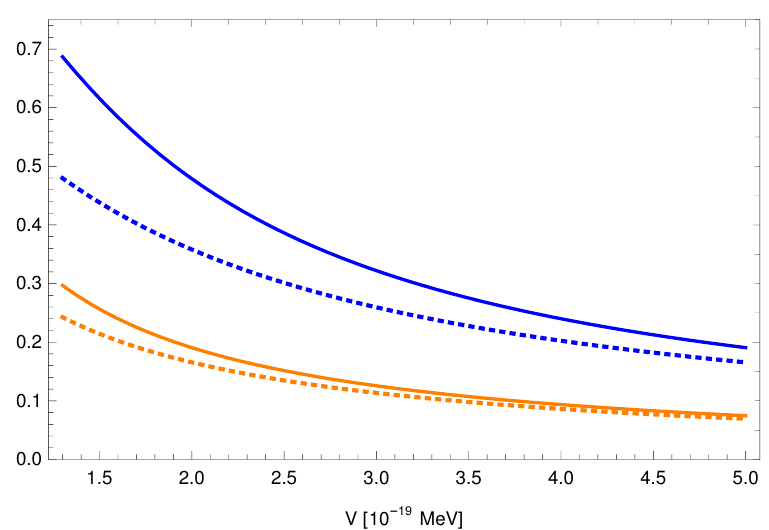
Figure 3 . sin 2 (cid:18) m in the matter for neutrinos (solid lines) and antineutrinos (dashed lines) as 12 the function of their interaction potential with Earth for energy E = 400 MeV (blue lines) and E = 1000 MeV (orange lines). Plots for the normal and inverted hierarchy do not di(cid:11)er.